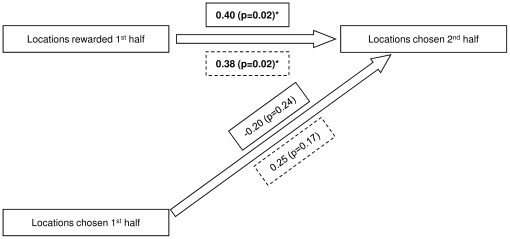
Manipulating the temporal properties of the foods during testing.Panel A shows on the left the four different cup holders (a, b, c & d) attached to the metal grid. On the right are the eight identical plain cups that were inserted into holders a–d in front of each subject. Two stacked cups were inserted into each cup holder. Only two of them contained food. In this example, a 1 hour apple sauce and red bell peppers trial, cup two contained red bell pepper and cup eight contained apple sauce. The remaining 6 cups were empty. Panel B shows that four cups were removed from the holders with the researcher's back to the subject, immediately after the food hiding. One of the plain cups was removed from each holder. In this example, upon recovery, holder a still contained the red bell pepper, while the apple sauce from holder d had disappeared.